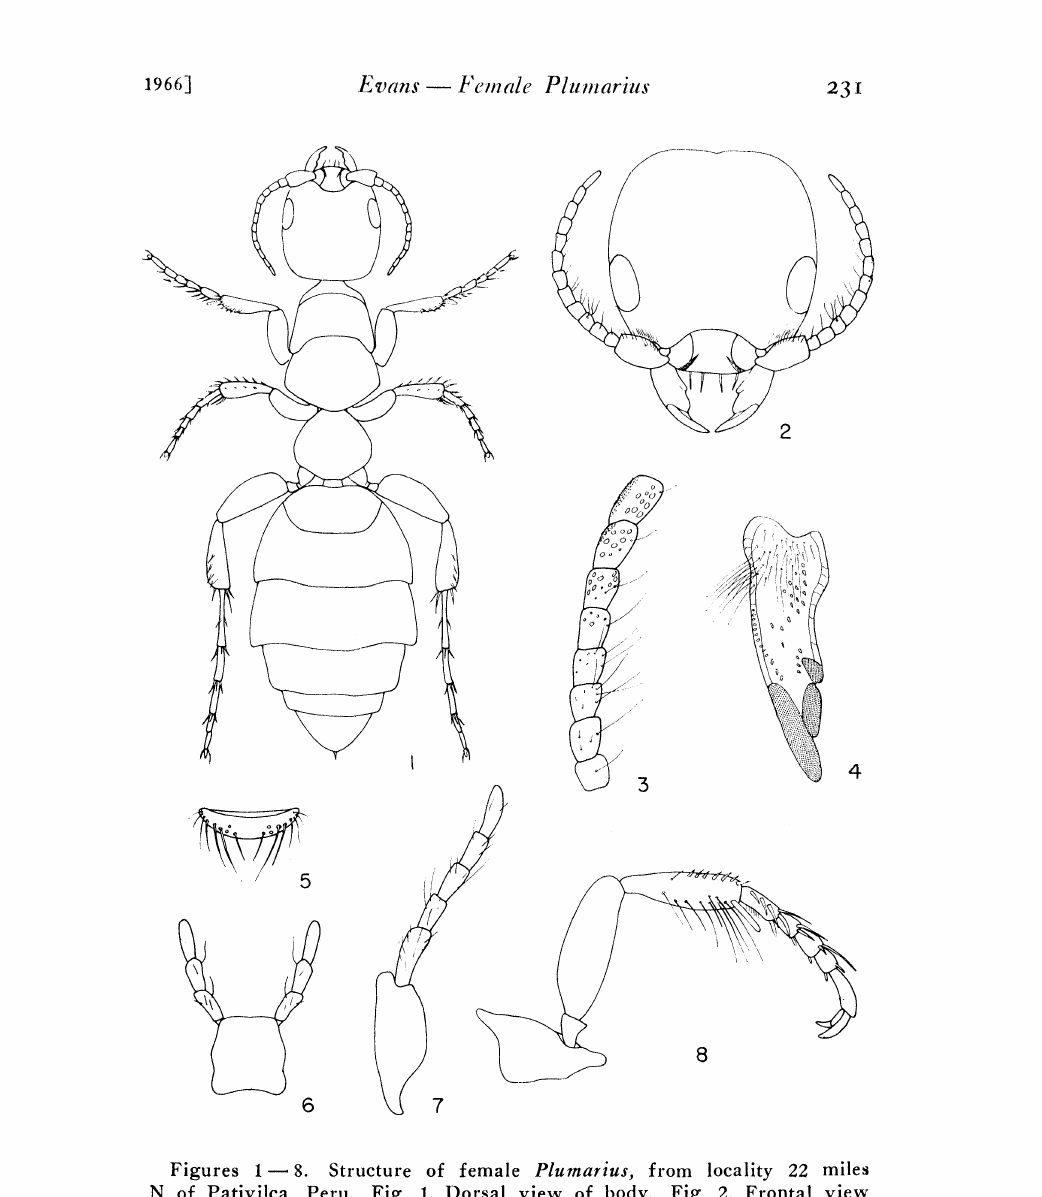
Figures 1---8. Structure of female Plumarius, from locality 22 miles N of Pativilea, Peru. Fig. 1. Dorsal view of body. Fig. 2. Frontal view of head. Fig. 3. Detail of antennal segments 2-9. Fig. 4. Mandible. Fig. 5. Labrum. Fig. 6. Labium. Fig. 7. Maxilla. Fig. 8. Front